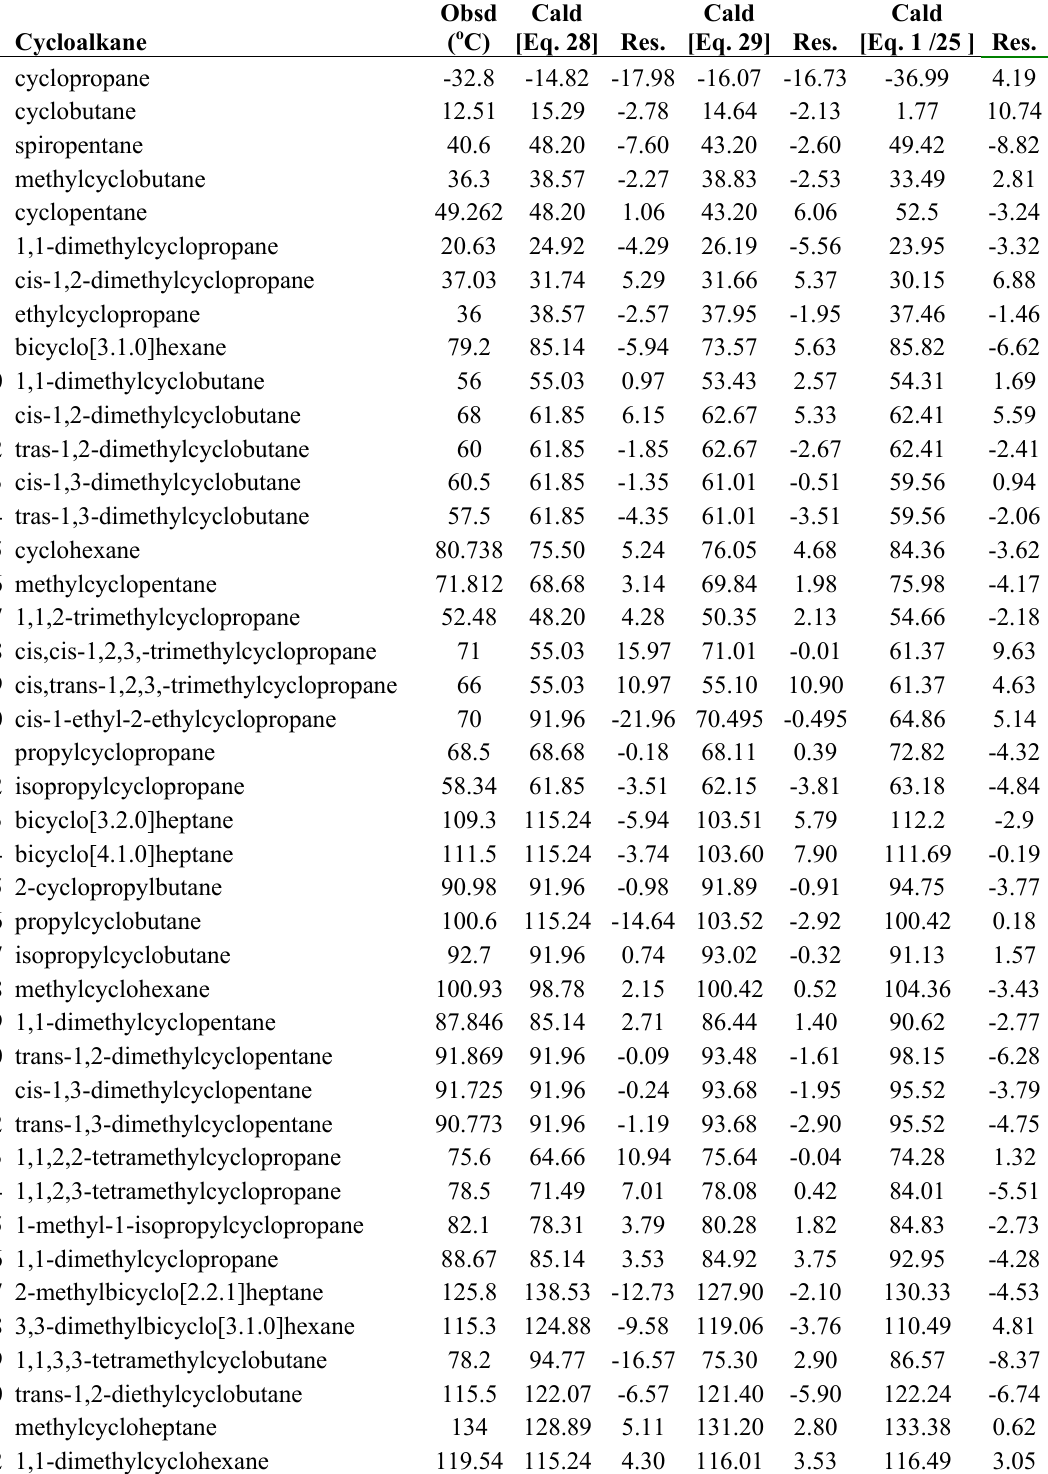
Table 12. Experimental and Calculated Bp of Cycloalkanes of the Training Set. no Cycloalkane